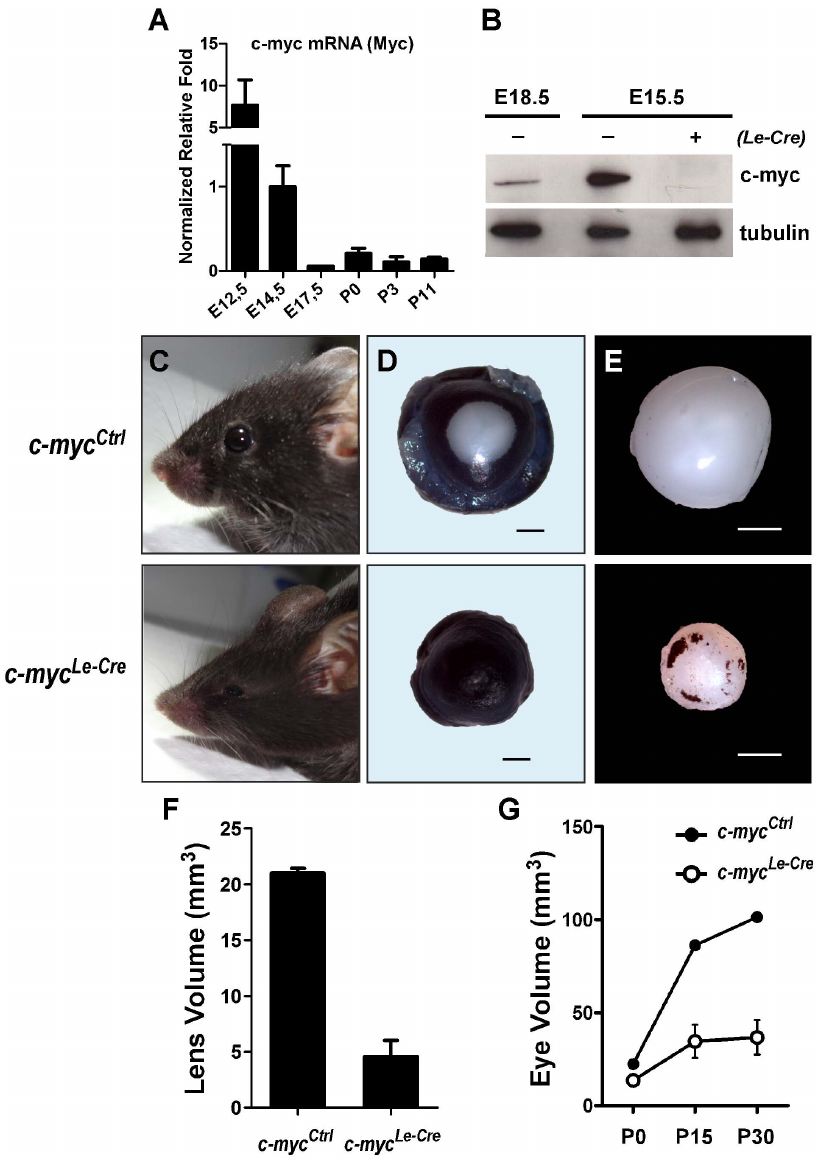
Figure 1. c-myc is highly expressed in developing mouse lens and genetic inactivation of c-myc in the surface ectoderm severely impairs lens and eye growth. ( A ) Real-time RT-PCR analysis of c-myc mRNA ( Myc ) expression at 6 stages of mouse lens development. Real-time RT-PCR data was obtained using TaqMan probes and datasets were normalized to actin ( Actb ). Normalized relative expression shows that Myc expression is highest in earliest stage analyzed (E12.5) and sharply decrease as development proceeds. ( B ) Western blot analysis of c-myc protein Expression ( C–E ) Representative pictures of c-myc Le-Cre and c-myc Ctrl mice (P60) ( C ), eyes (P15) ( D ) and lens (P30) at the indicated ages ( E ). ( F ) Measurement of lens volume at P30 shows that inactivation of c-myc in developing lens leads to a severe reduction of the lens volume ( c-myc Le-Cre ; n=8; c-myc Ctrl ; n=6). ( G ) Inactivation of c-myc in the developing lens dramatically impairs eye growth as observed by the reduction of eye volume already at birth (P0; c-myc Le-Cre ; n=18; c-myc Ctrl ; n=14). Eye growth impairment was observed throughout postnatal development (P15; c-myc Le-Cre ; n=6; c-myc Ctrl ; n=4) and adulthood (P30; c-myc Le-Cre ; n=20; c-myc Ctrl ; n=12). A t-test was performed for ( F ) and a two-way ANOVA test was performed for ( G ). Error bars indicate SEM; *** p , 0,